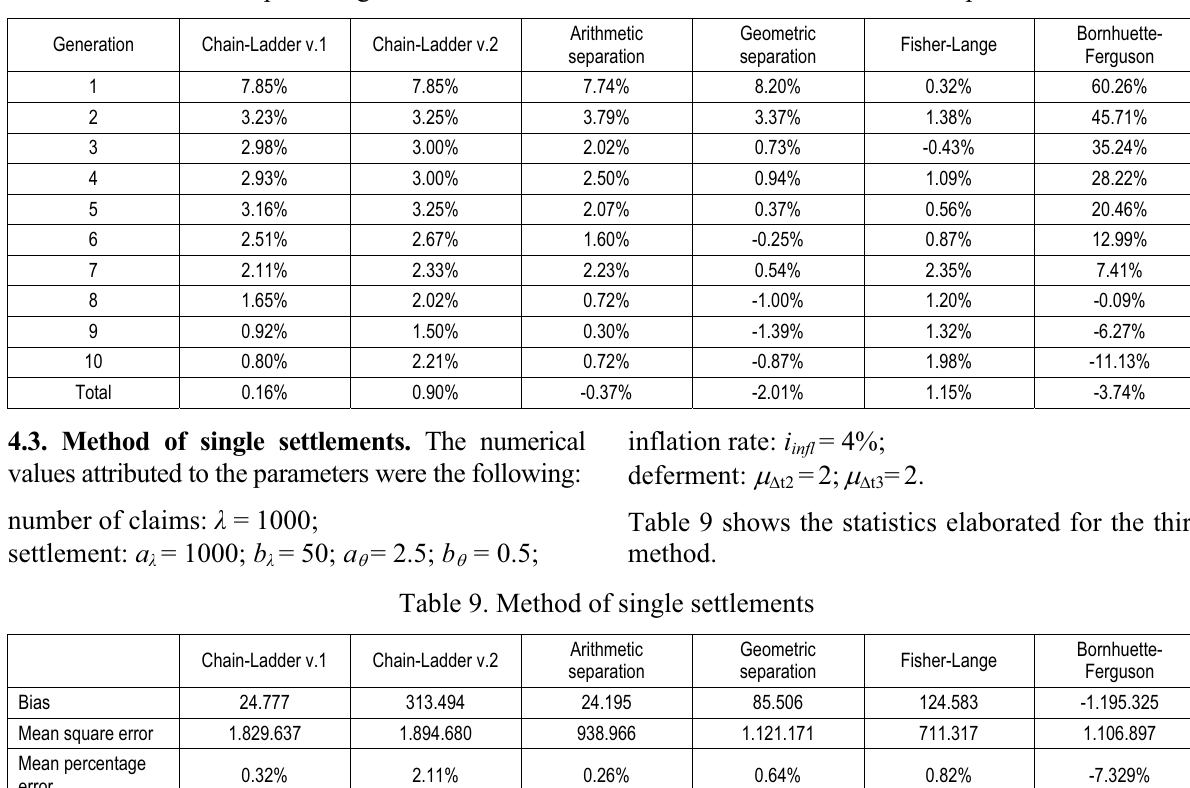
Table 8. Mean percentage error method of backward calculated random development factors